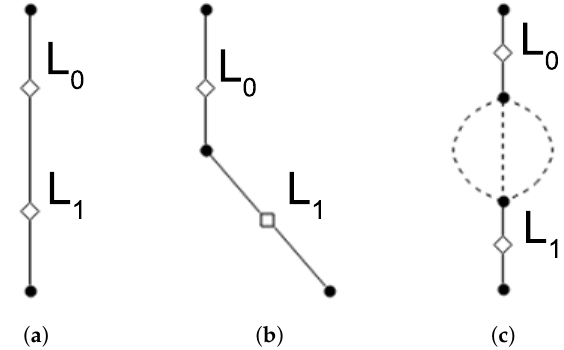
Figure 5. Different situations depending on locations. ( a ) Two locations in the same arcs; ( b ) Two locations in neighboring arcs; ( c ) Two locations in non-neighboring